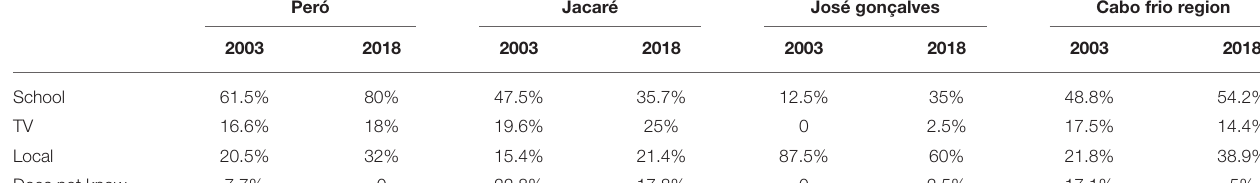
TABLE 5 | Diachronic analysis comparing the changes in the origin of the knowledge between Cabo Frio region residents over 15 years.